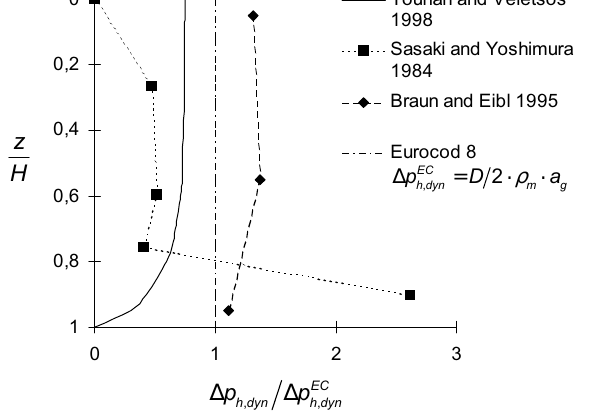
Fig. 1. Comparison of horizontal pressure distributions according to various